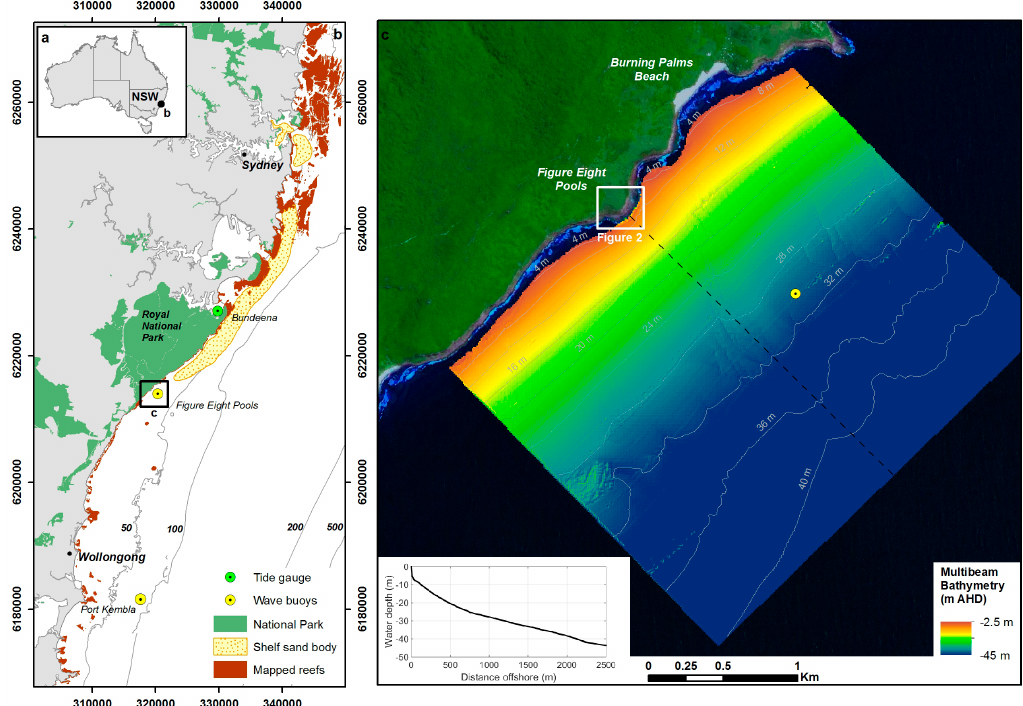
bathymetric profile along the dashed line. Adapted from